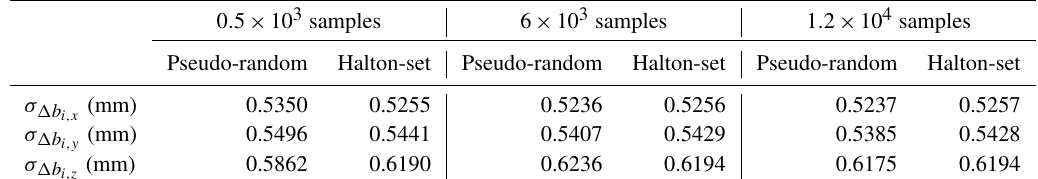
Table 3. Standard deviations σ of the L/R mechanism output error with pseudo-random and Halton-set based MC simulation.